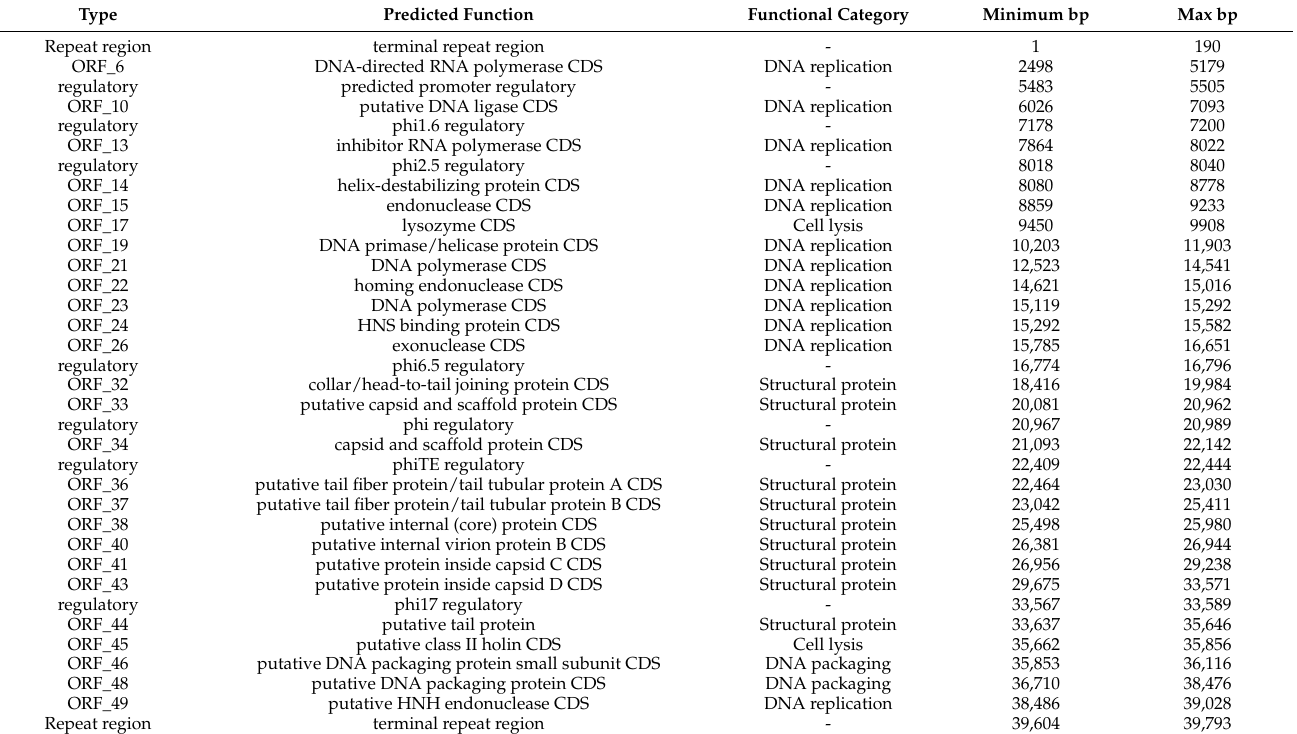
Figure 1. Genome map of phage Ro45lw was generated using the CGview server beta. ORFs are annotated and colored based on predicted molecular functions of identified genes (Table 1). The center of the genome map provides % GC content (black). Table 1. List of annotated ORFs with known predicted functions, size, and location in the Ro45lw